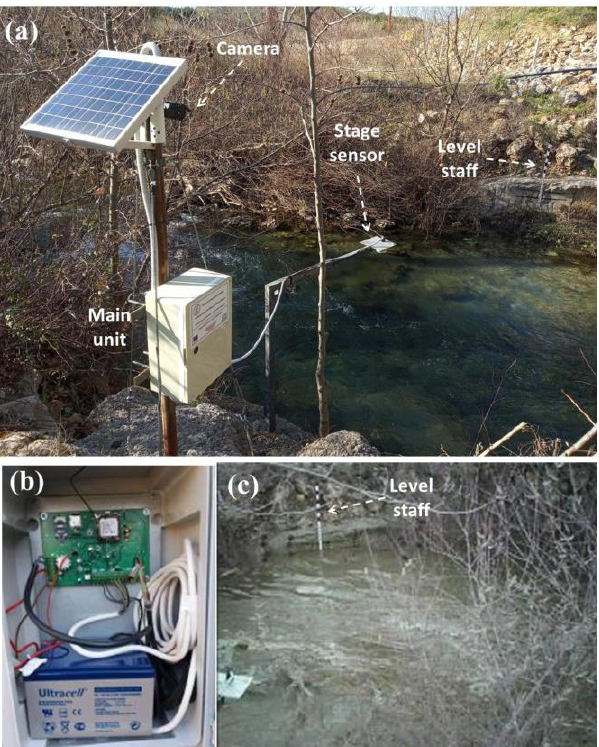
Figure 9. ( a ) Station equipped with main unit, ultrasound stage sensor, air temperature probe, solar panel, VGA camera, antenna and conventional level staff, ( b ) box containing the station’s main unit, ( c ) shot taken automatically by the VGA camera.